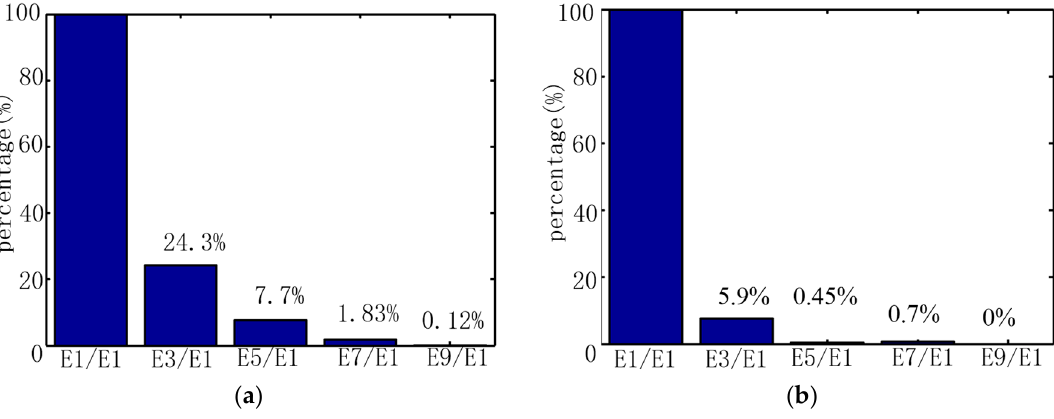
Figure 11. Back − EMF harmonic analysis of two FPMSMs: ( a ) THI − FPMSM; ( b ) SIN −